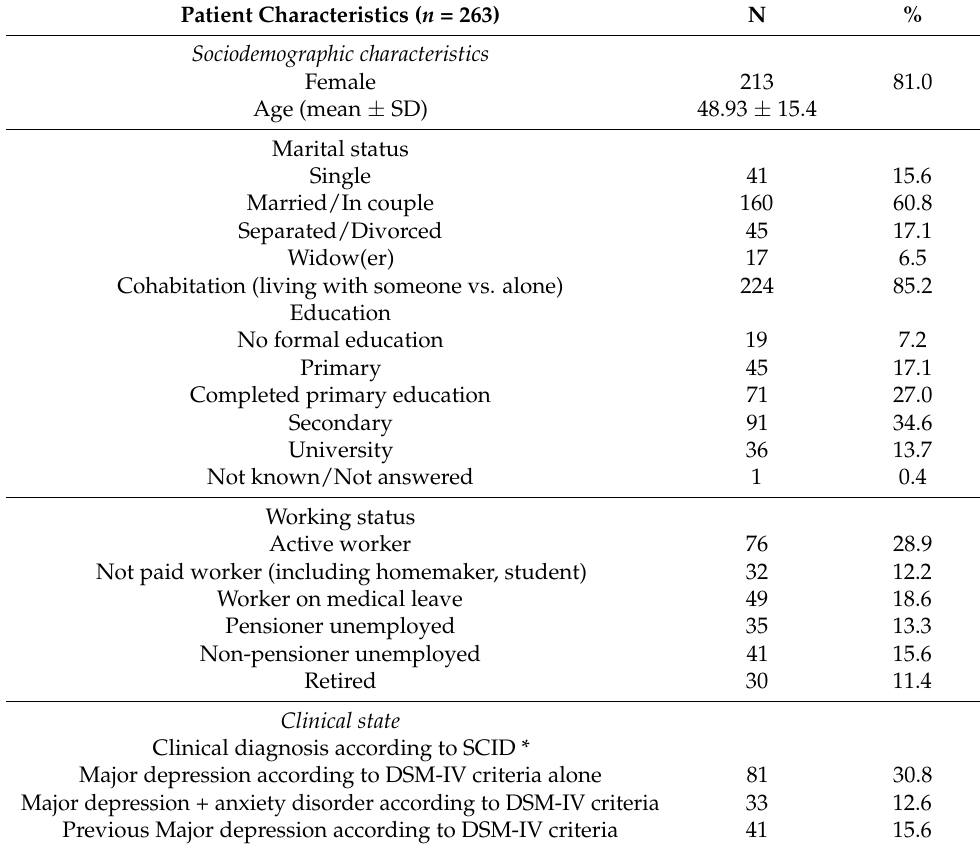
Table 1. Characteristics of patients and Family Phyisicans at